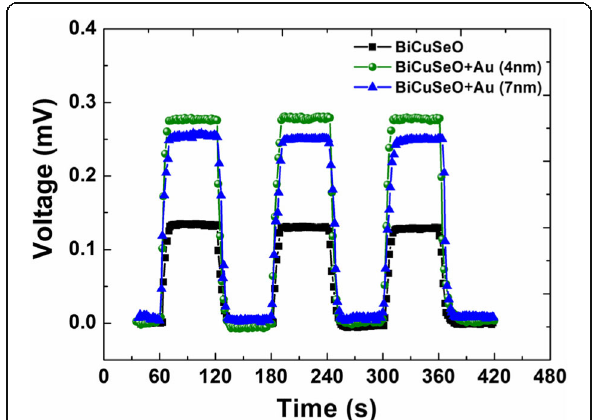
Fig. 3 Voltage responses of bare BiCuSeO and AuNPs/BiCuSeO samples upon a Xenon illumination